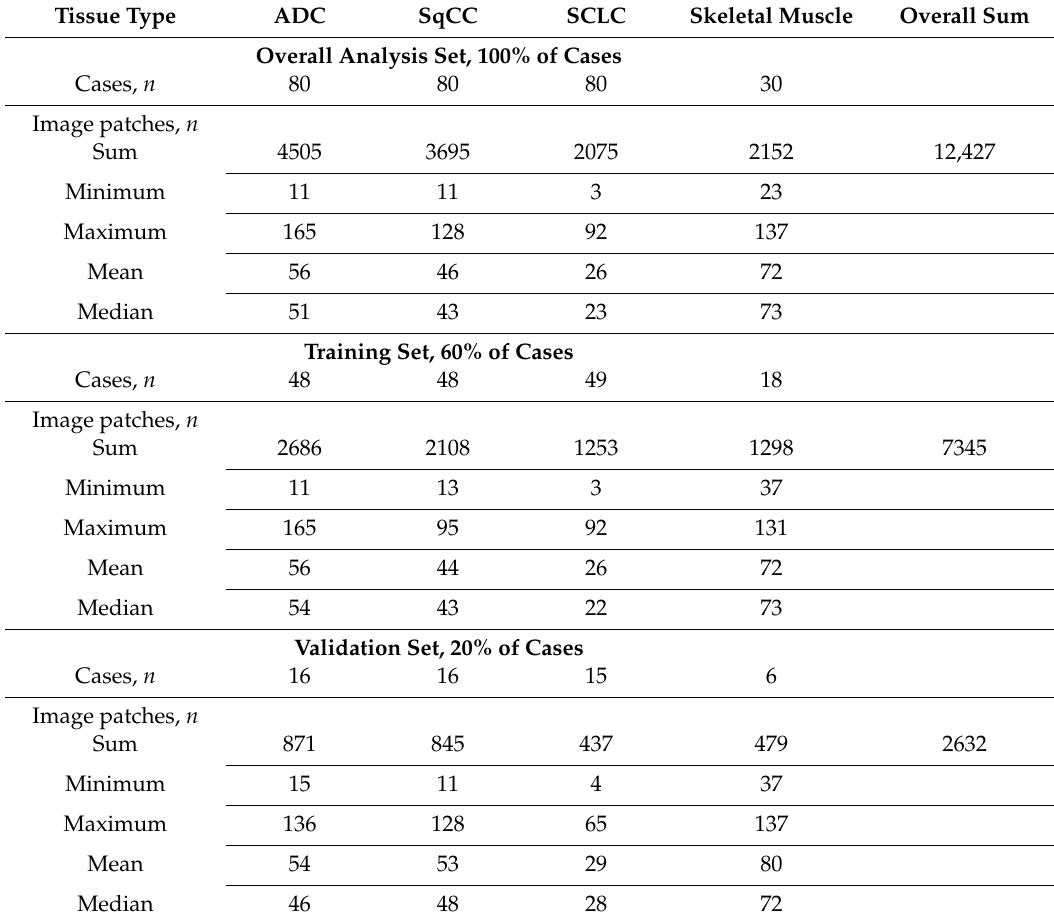
Table 1. Descriptive statistics of annotated image patches and analysis